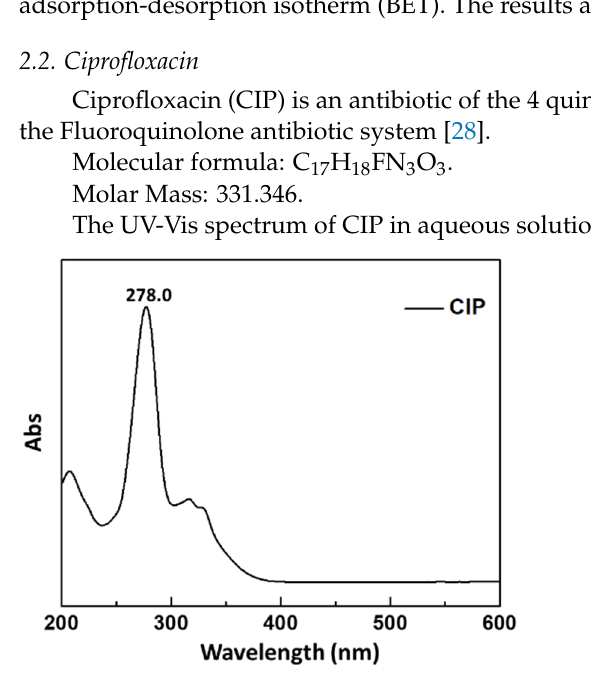
Figure 1. UV-Vis Spectrum of CIP, concentration 10 mg/L, pH = 3.